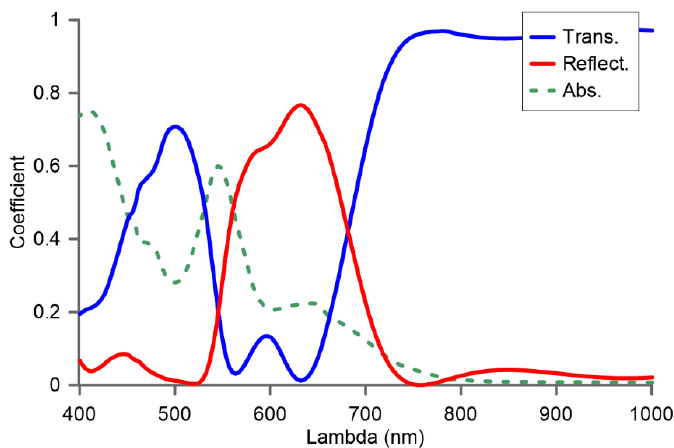
Figure 5. Power absorption, reflectance and transmittance coefficients for a metasurface made of Si nanopillars with h = 160 nm, r = 74 nm and distance between them of d = 100 nm.